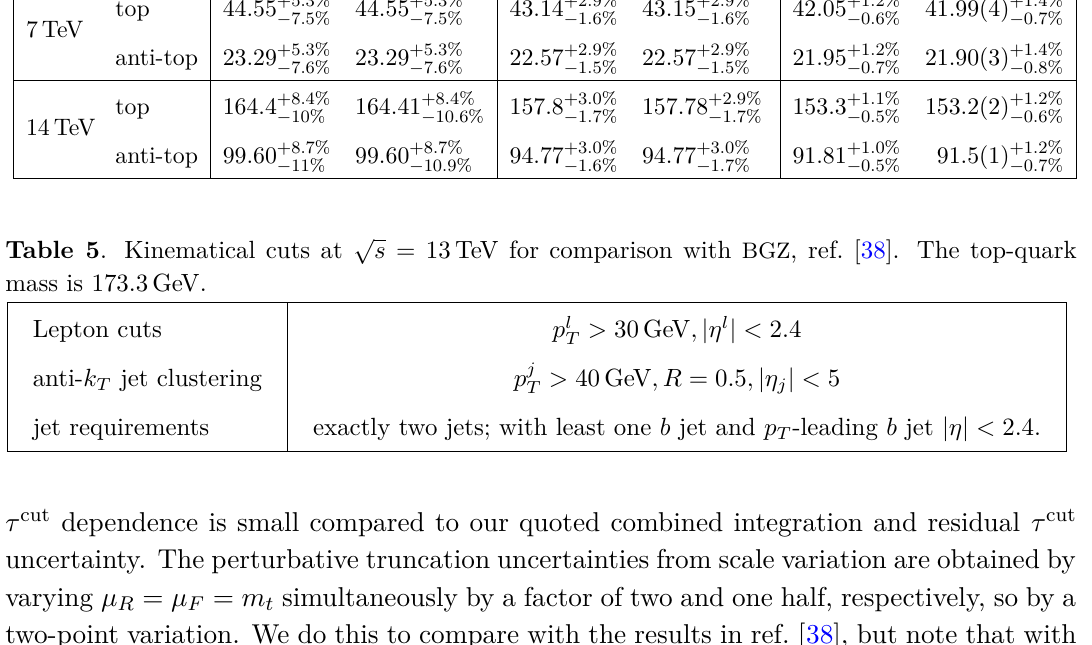
Table 4 . Comparison with fully inclusive production results from Berger, Gao, Zhu [37, 38]. Scale uncertainties in super- and subscript from simultaneous variation of µ R = m t and µ F = m t by a factor of two and one half, respectively.